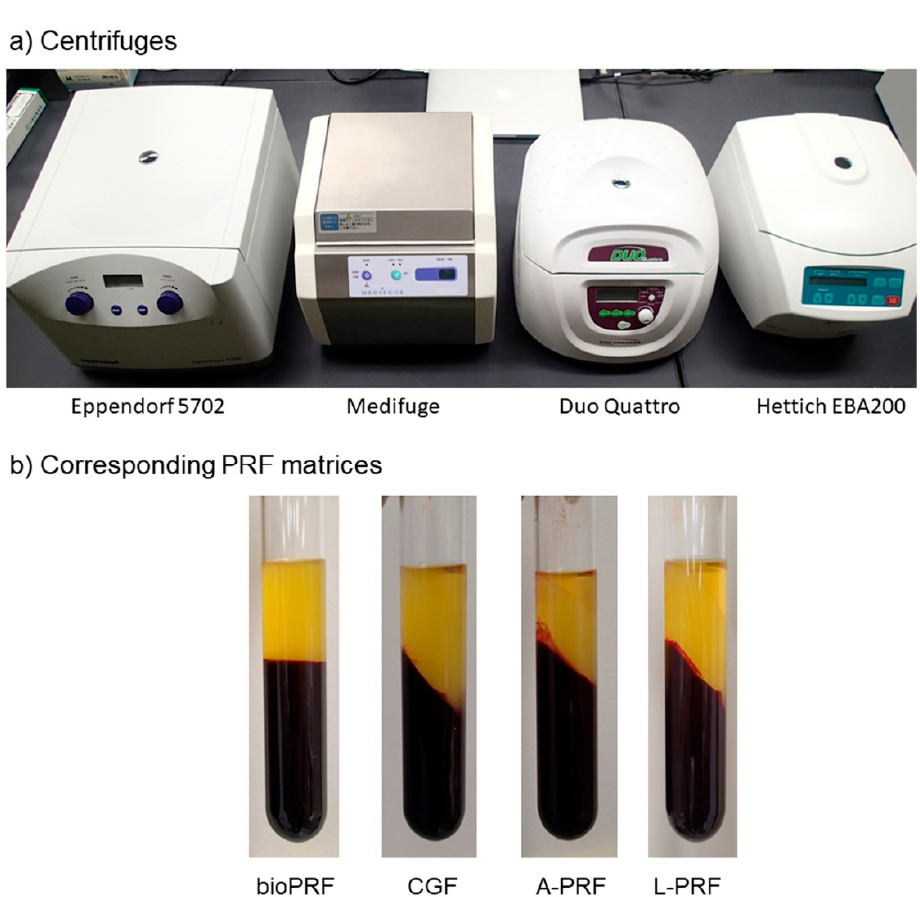
(Table 1). Depending on the protocols of the individual centrifuges, distinguishable PRF matrices were formed (Figure 6b). Int. J. Mol. Sci. 2020 , 21 , x FOR PEER REVIEW